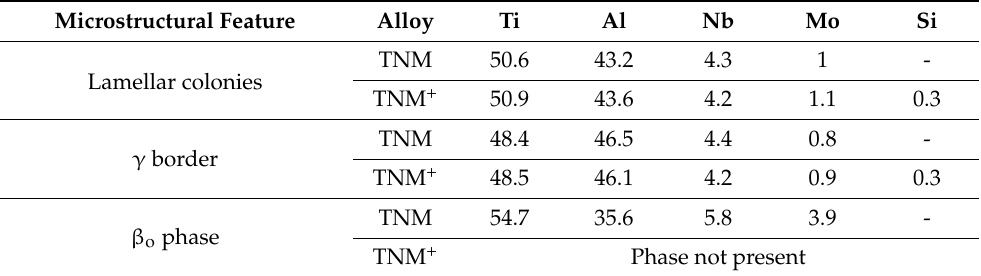
Table 3. Quantitative elemental analysis by EDS at the local scale of the TNM and TNM + alloys densified at 1325 °C. The size of the analysed area was adapted to the size of the investigated fea- tures of the microstructure. The values are given in at.% and the accuracy of these measurement is within 0.2.